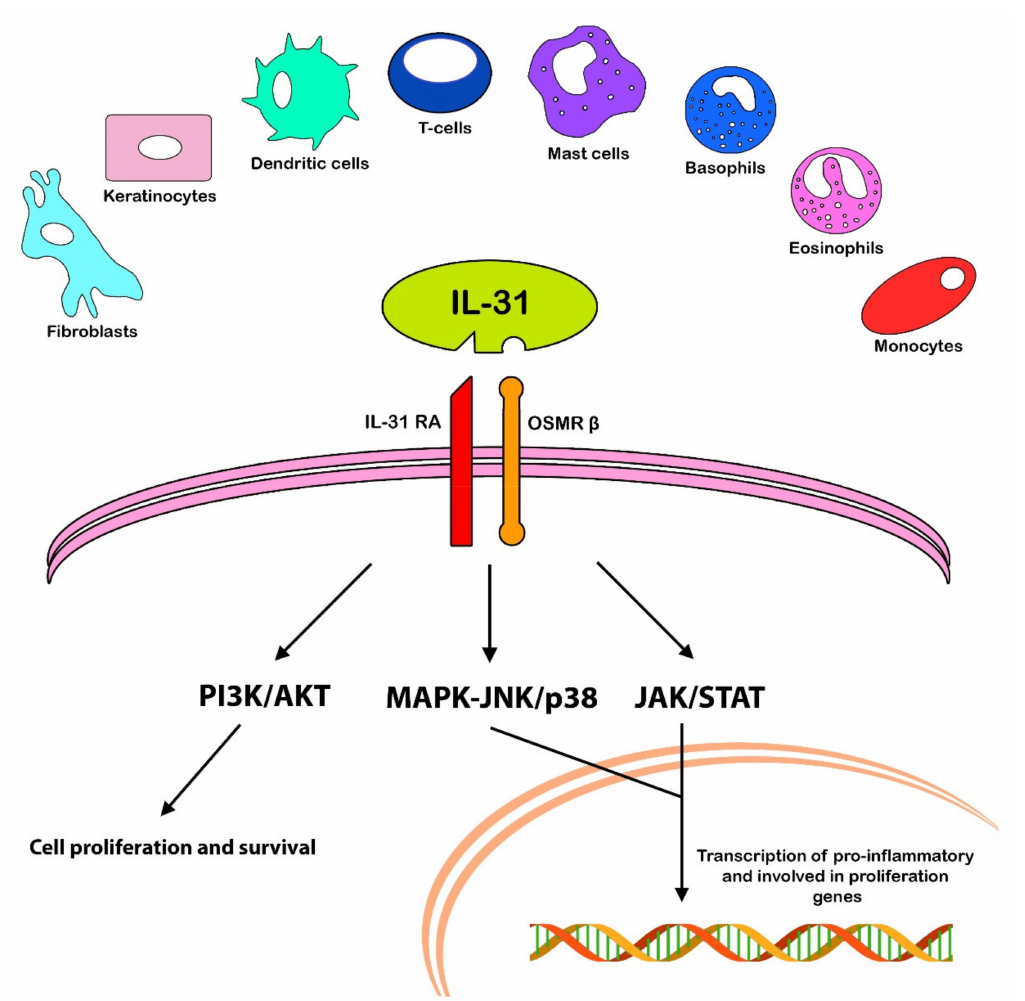
Figure 1. Representation of the main cells involved in the production of IL-31 and the three intracellular-signaling pathways, which are activated following the binding of IL-31 with its